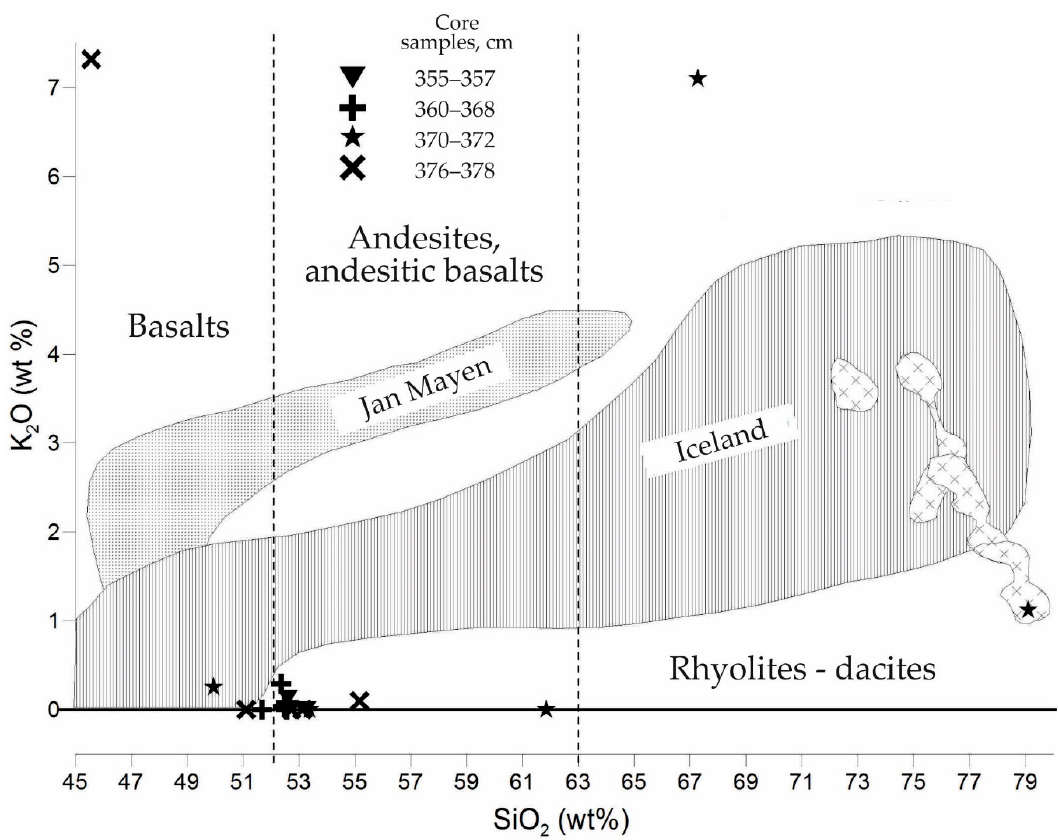
Figure 12. Position of the eruptive shards from the ash-bearing core unit of 355–378 cm in the binary SiO 2 / K 2 O system according to [24]. All data on our samples are from the polished thin sections. Areas of the volcanic material from different sources are according to [25,26].